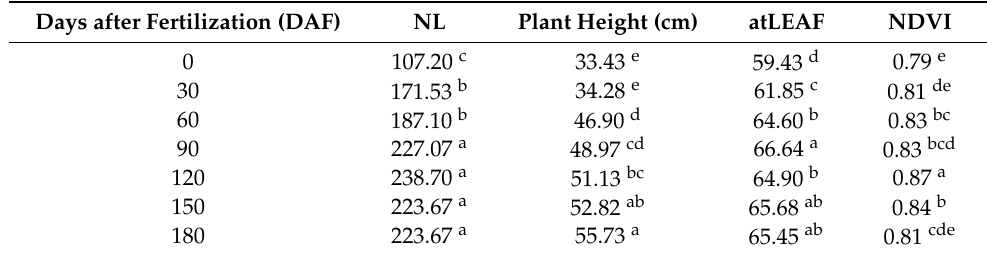
Table 3. Number of leaves (NL) , plant height, relative chlorophyll content (atLEAF), and normalized difference vegetation index (NDVI) of cocoplum at 0, 30, 60, 90, 120, 150, and 180 days after fertilization. Days after Fertilization (DAF) NL Plant Height (cm) atLEAF NDVI 0 107.20 c 33.43 e 59.43 d 30 171.53 b 34.28 e 61.85 c 187.10 b